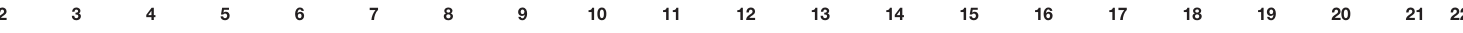
TABLE 3 | Bivariate correlations between all elements of the study and effect